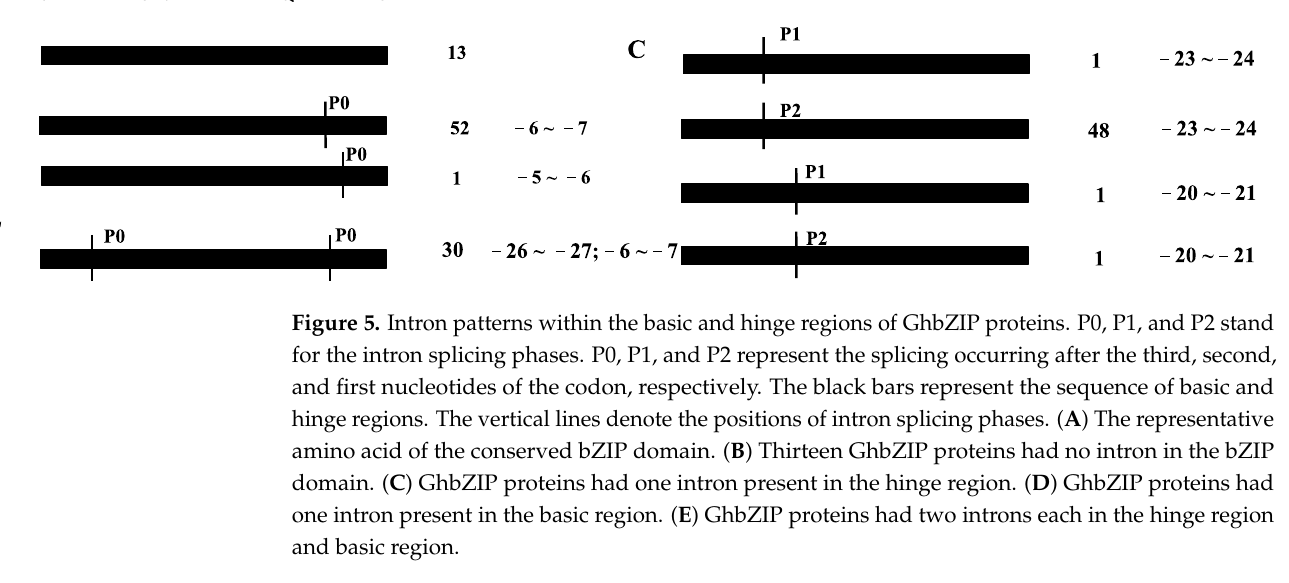
Table 1. Predicted DNA binding site of GhbZIP transcription factors.